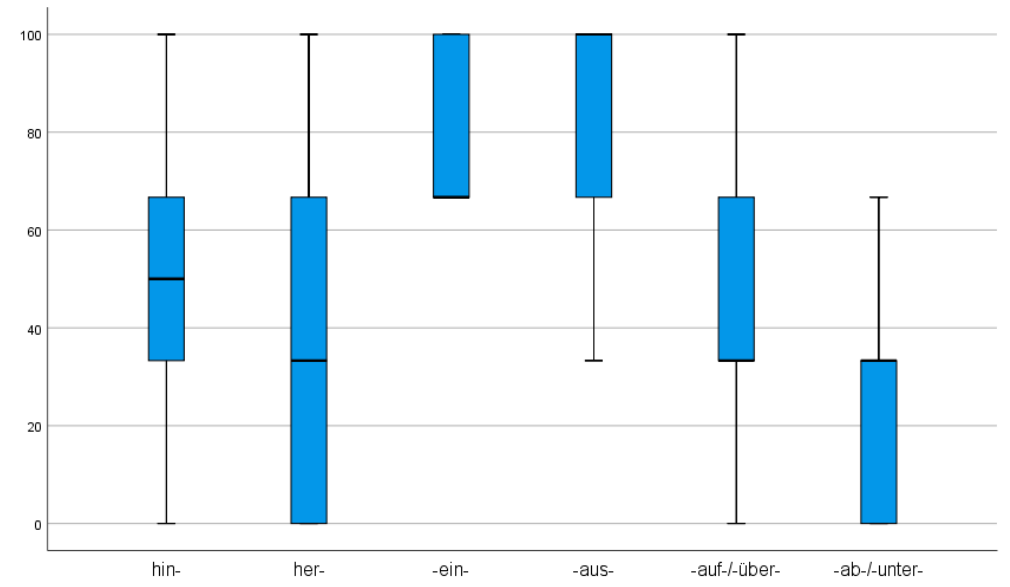
Figure 10. Boxplot: Results of the interpretation pretest per subcondition.